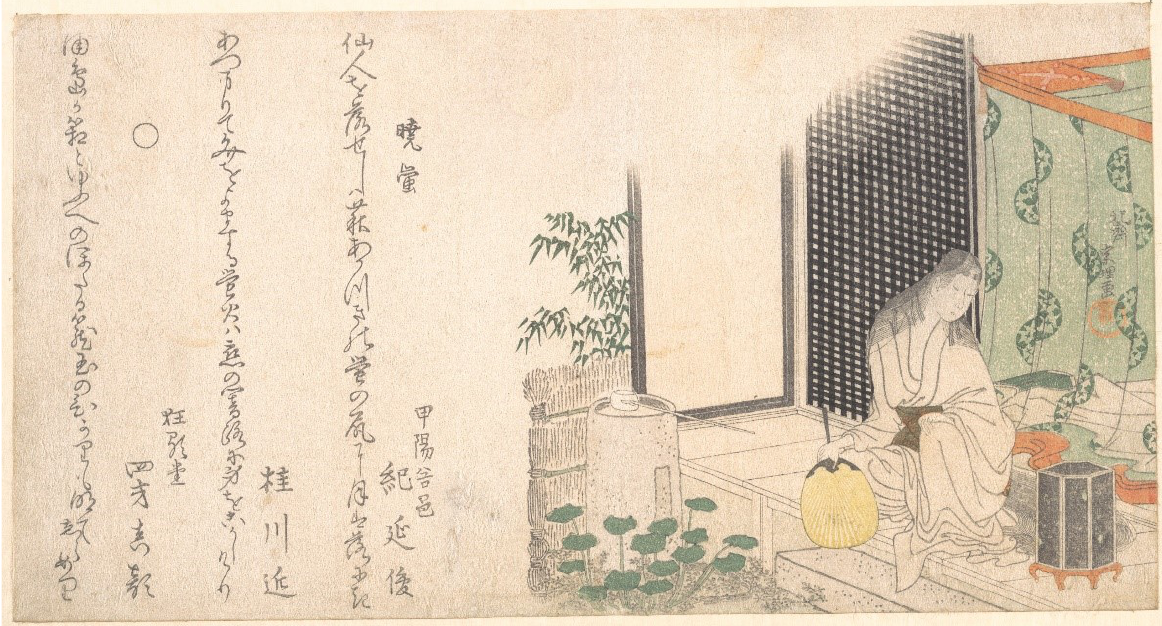
Figure 7. (T41). Cage of Fireflies at Dawn in Summer. ca. 1800. Katsushika Hokusai [Japanese, Tokyo (Edo) 1760–1849]. Woodblock print (surimono); ink and color on paper. The Howard Mansfield Collection, Purchase, Rogers Fund, 1936. Accession Number: JP2577. The Metropolian Museum of Art, New York, NY, USA, www.metmuseum.org (accessed on 4 January 2022). Open access image, CC0.